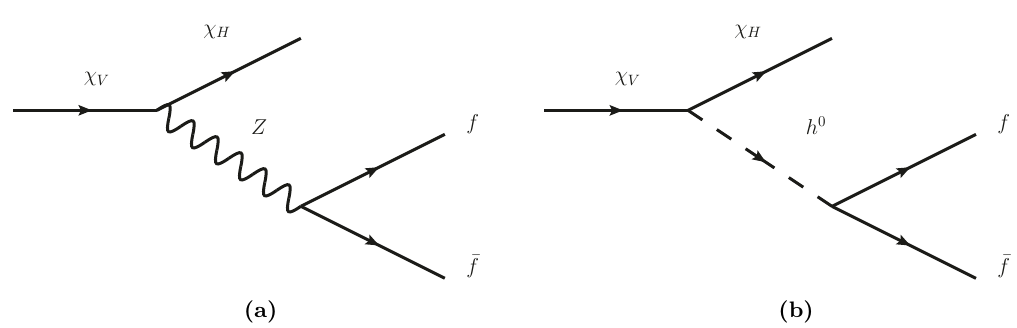
Figure 5. (a) Three-body decay of visible LSP (cid:31) V into hidden gaugino (cid:31) H and Standard Model fermions via an o(cid:11)-shell Z boson. (b) As in a), but via an o(cid:11)-shell Higgs